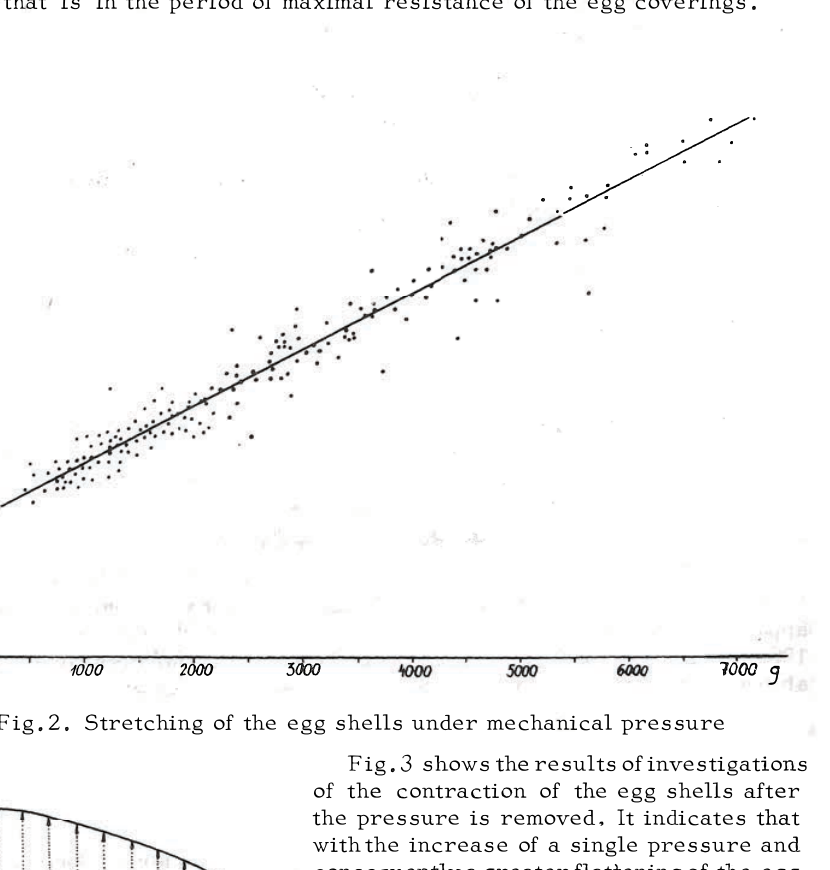
Fig.3. Egg covering resilience in relation to the magnitude of the